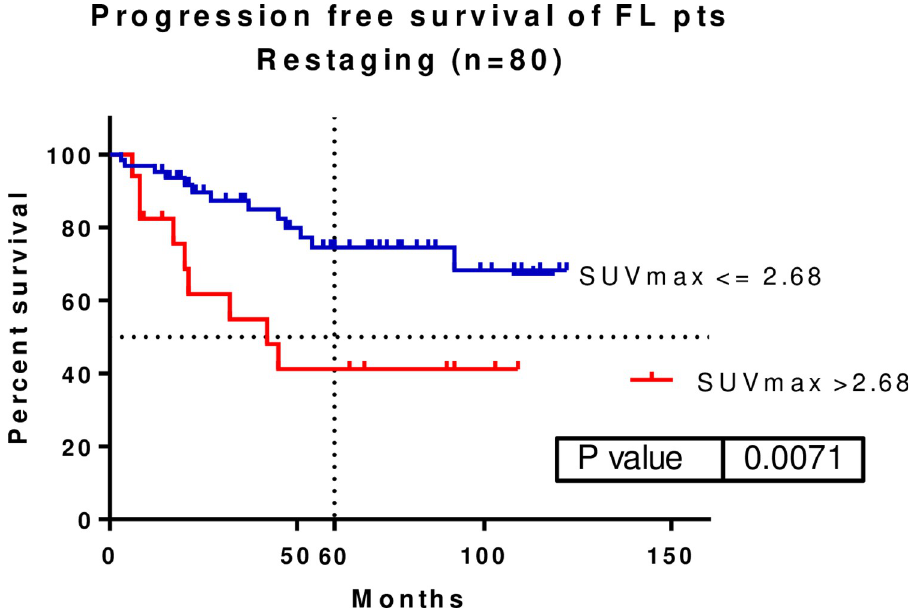
Fig 3. A significant progression-free survival (PFS) difference was shown with a SUVmax cut-off of 2.68 at the restaging PET/CT (p = 0.0071, HR: 0.2276, 95%CI: 0.07753–0.6683). Five-year PFS was 74.48 vs. 41.17% SUVmax– maximum of standardized uptake